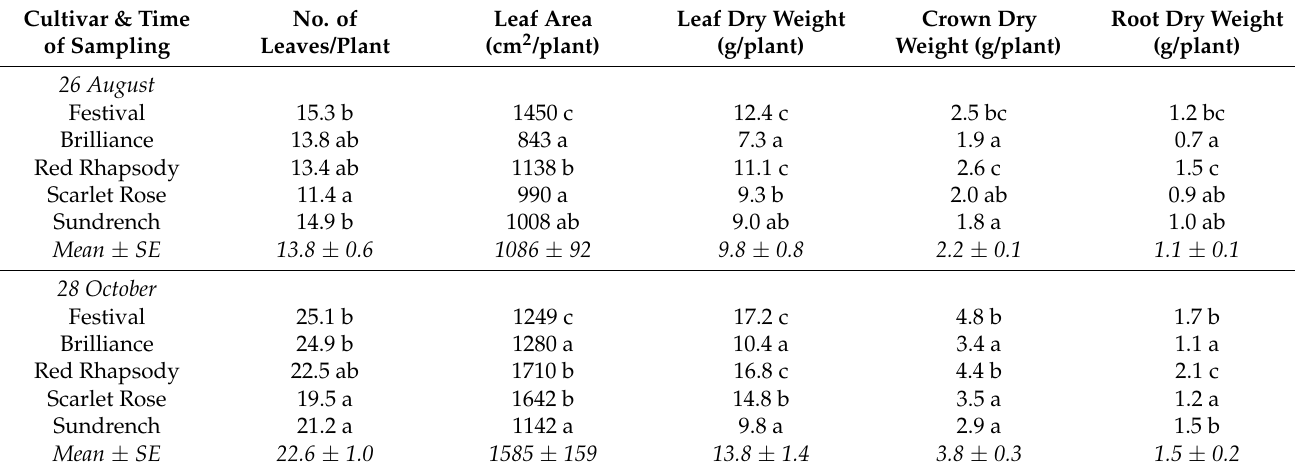
Table 2. Variations in the number of leaves/plant, leaf area/plant and plant dry weight (leaves, crowns, and roots) in five strawberry cultivars in Queensland. Data are the means of six replicates per cultivar and were collected on 26 August or on 28 October. Means in a column for each harvest followed by a common letter are not significantly different by the Fisher’s least significant test at 5% level of significance. Means ± (SE or standard error) across all the cultivars for each harvest also presented.